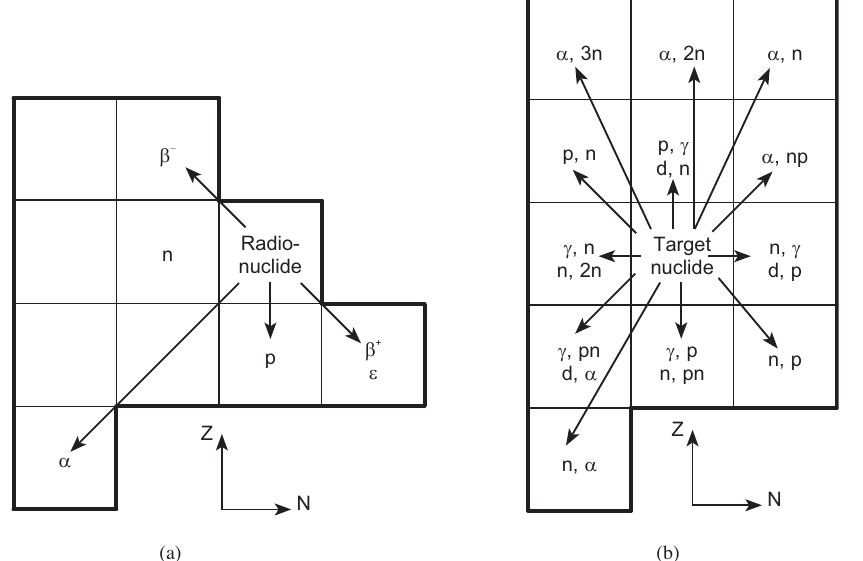
Fig. 9. (a) Radioactive decay processes on the nuclide chart. A “ parent ” with coordinates Z, N transforms to the “ daughter ” product through the decay process shown. (b) Activation processes and nuclear reactions on the nuclide chart. A target nuclide with coordinates Z, N transforms to the nuclide Z ’ , N ’ through the processes shown. The reaction can be written Z+N X(a,b) Z ’ +N ’ Y where a and b are the incident and exiting particles respectively.